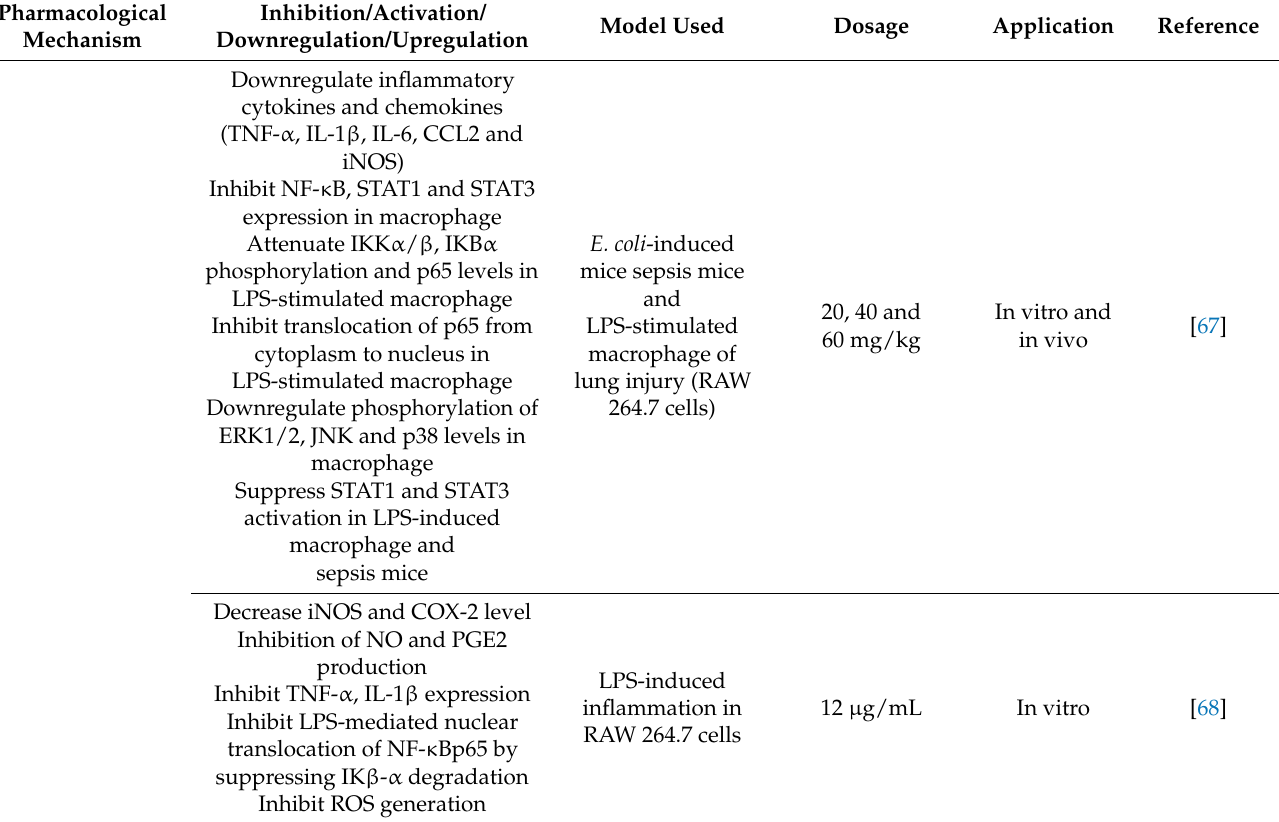
Table 3. Mechanism and function of esculetin in treatment of